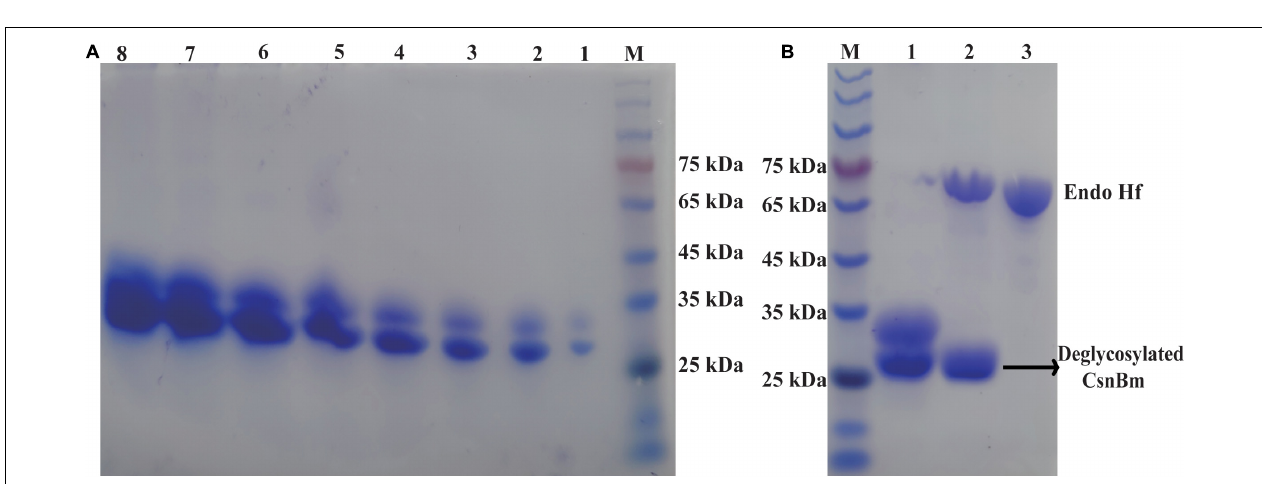
FIGURE 2 | SDS-PAGE analysis of CsnBm. (A) Supernatant from different induction time in 50-L bioreactors. M, marker, lanes 1–8 represent supernatant from 24 to 192 h. (B) Purified and EndoH f treatment CsnBm. M marker, lane 1: purified CsnBm, lane 2: Deglycosylated CsnBm and Endo H f , lane 3: Endo H f .